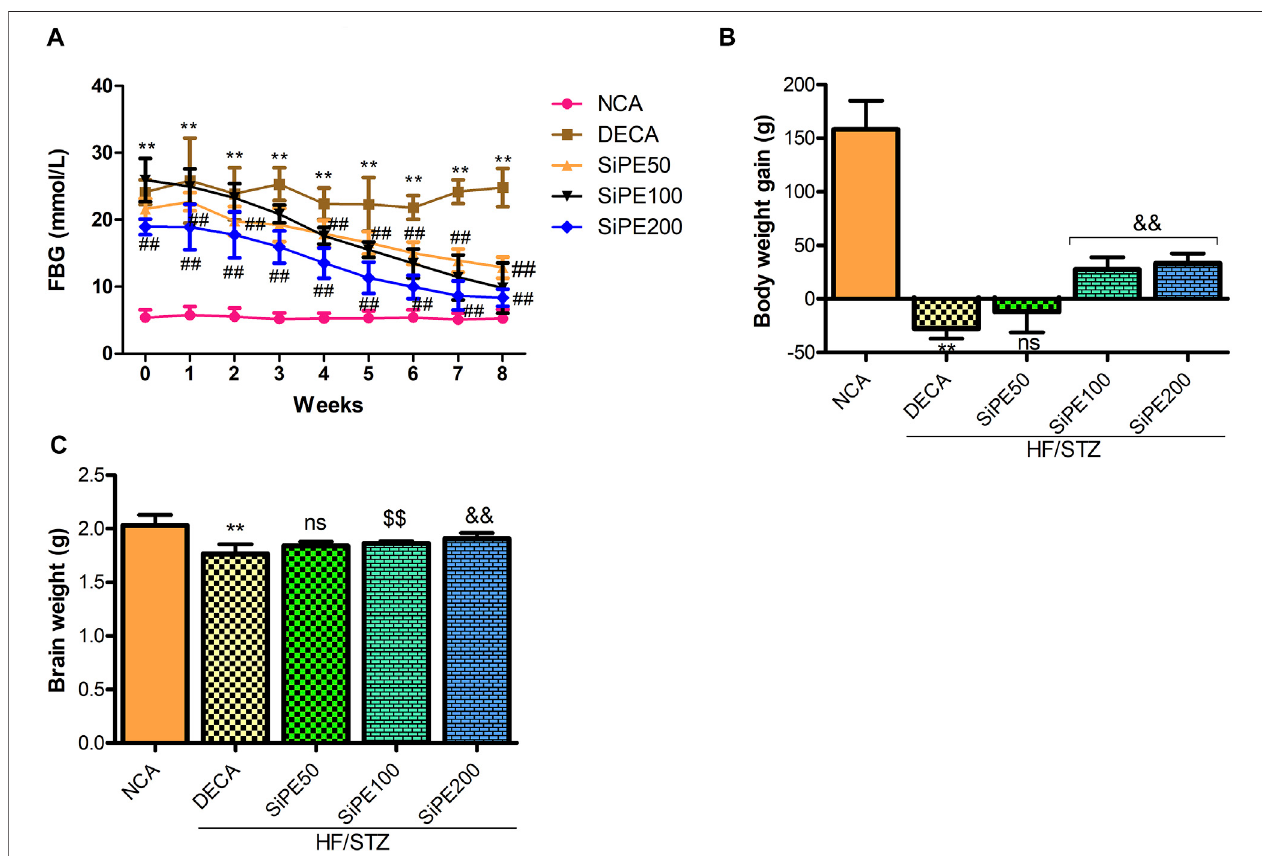
FIGURE 2 | Effect of SiPE treatment on biochemical features in HF/STZ-induced diabetic encephalopathic rats. SiPE treatment at dose of 50, 100 or 200 mg/kg signi fi cantly reduced (A) fasting blood glucose levels. SiPE treatment at dose of 100 or 200 mg/kg signi fi cantly (B) improved body weight gain and (C) brain weight compared to DECA group. Data are presented as mean ± SD ( n (cid:2) 6) and one-way ANOVA test was applied. ** p < 0.001 indicates statistical signi fi cance compared to NCA group. ## p < 0.001, && p < 0.01 and $$ p < 0.05 indicate statistical signi fi cance compared to DECA group. ns: not signi fi cant compared to DECA